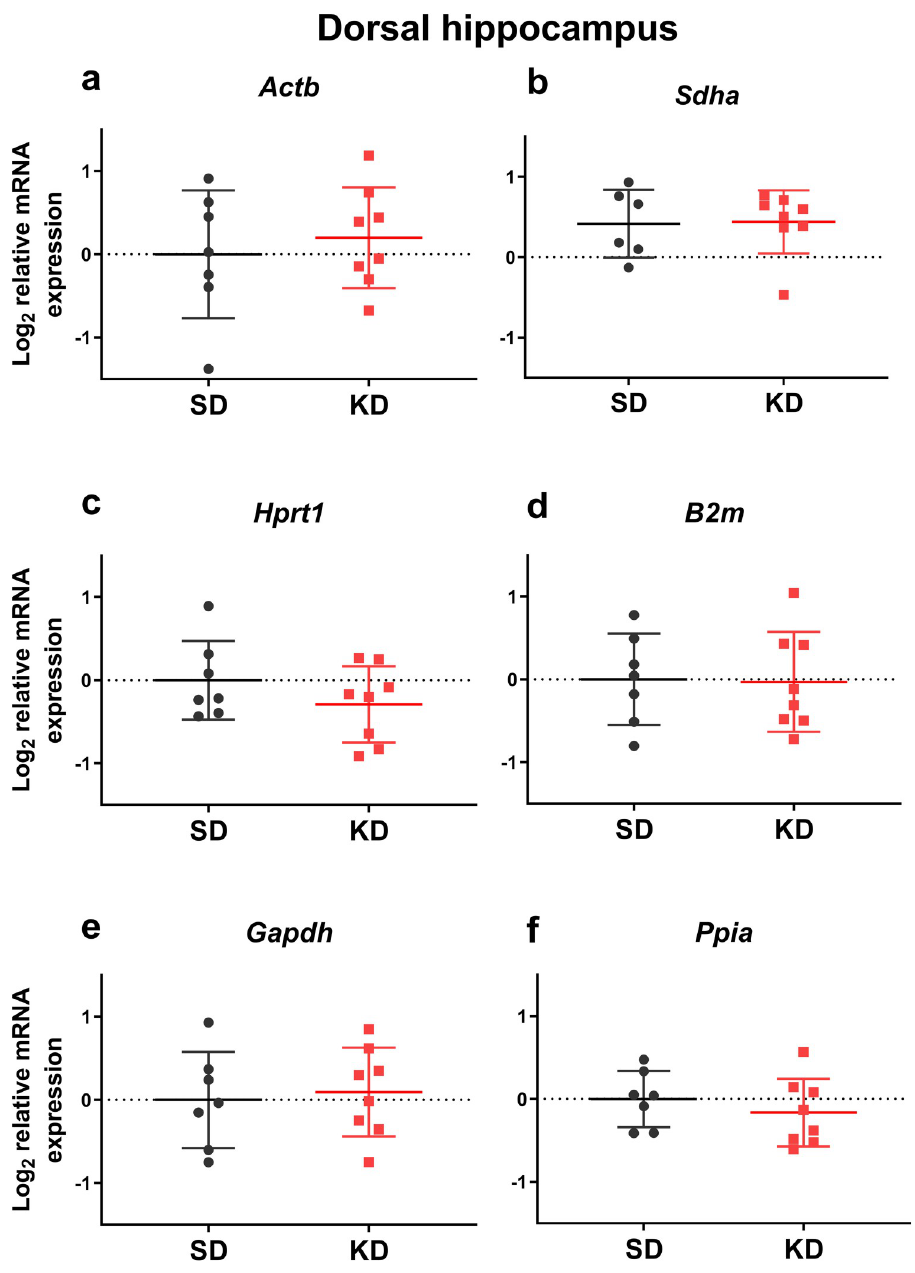
Fig 5. The effects of medium-chain triglyceride supplementation for 1 month on the mRNA expression of reference genes in the rat dorsal hippocampal area. MCT (2 ml/kg body weight) were given as a supplement to standard feed to adult animals (9 m.o., BW = 444 ± 69 g) by oral gavage daily for 4 weeks (KD), while the control rats received equivolume water (SD). The mRNA expression was normalized to the geometric mean of the expression level of the three most stably expressed genes ( Rpl13a , Ywhaz , Pgk1) . The reference gene stability rankings significantly differed in the dorsal and ventral hippo- campal areas. For example, Sdha expression was one of the most stable in the ventral hippo- campus, while in the dorsal hippocampus, it had low stability and is, therefore, inappropriate for RT-qPCR data normalization. It is well known that dorsal and ventral hippocampal areas